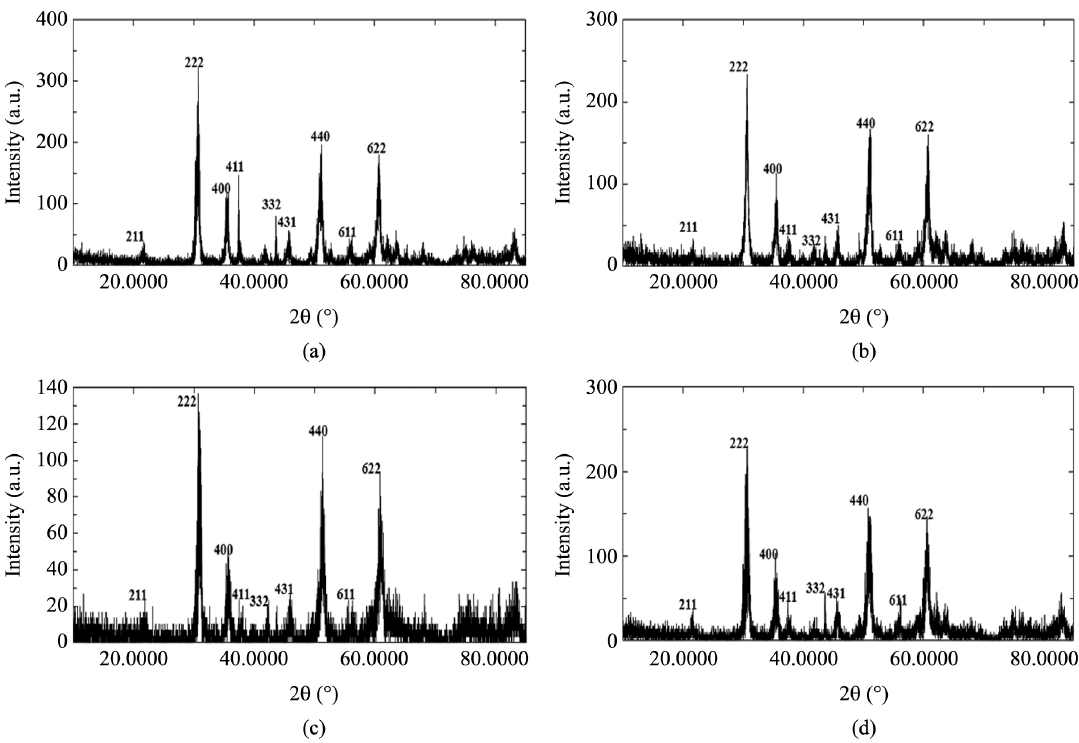
Figure 2. XRD patterns of the as-synthesized In c) Un-irradiated AcAc and SDS; d) γ-irradiated AcAc (10 2 kGy) and SDS.